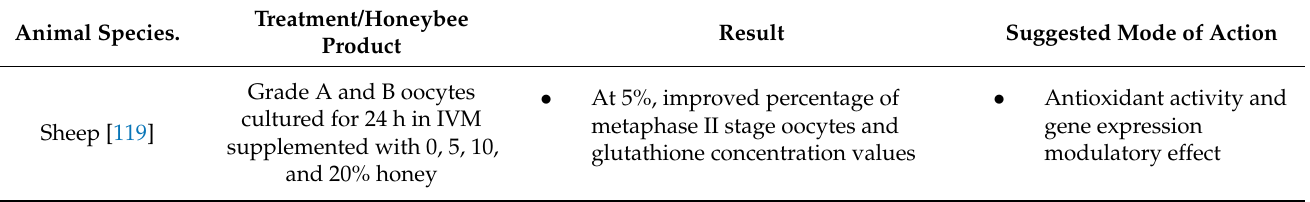
Table 6. Effect of honeybee products on assisted reproductive techniques (ARTs) in females. Animal